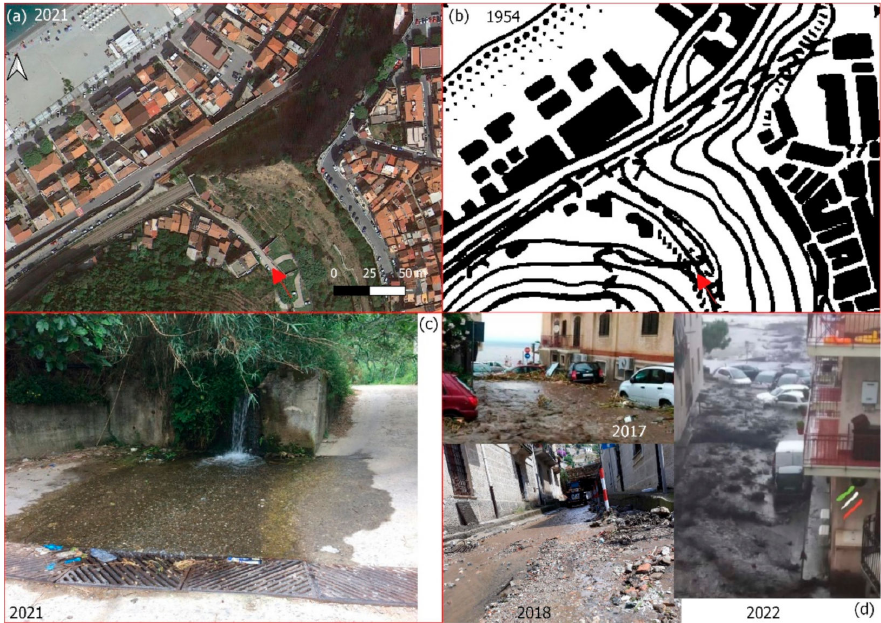
Figure 12. The Fosso Marina Grande River. ( a ) An image from Google Earth from September 2021. ( b ) The CASMEZ cartography from 1954. ( c ) The point where the natural river becomes artificial. ( d ) The effect of the rainfall events of 2017, 2018 and 2022. The arrows identify the upstream section of the